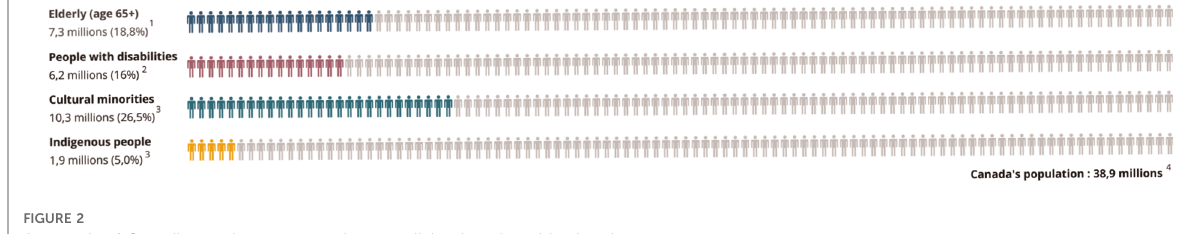
FIGURE 2 A portrait of Canadian underrepresented groups living in vulnerable situations. 1. Statistics Canada. (2022). Demographic estimates by age and sex, provinces and territories: Interactive dashboard [Data visualization tool]. Ottawa. Released July 1, 2022. https://www.statcan.gc.ca/en/subjects-start/older_adults_and_population_aging 2. Statistics Canada. (2019). Persons with disabilities and COVID-19 [Infographic]. Ottawa. Released July 6, 2020. https://www150.statcan.gc.ca/n1/